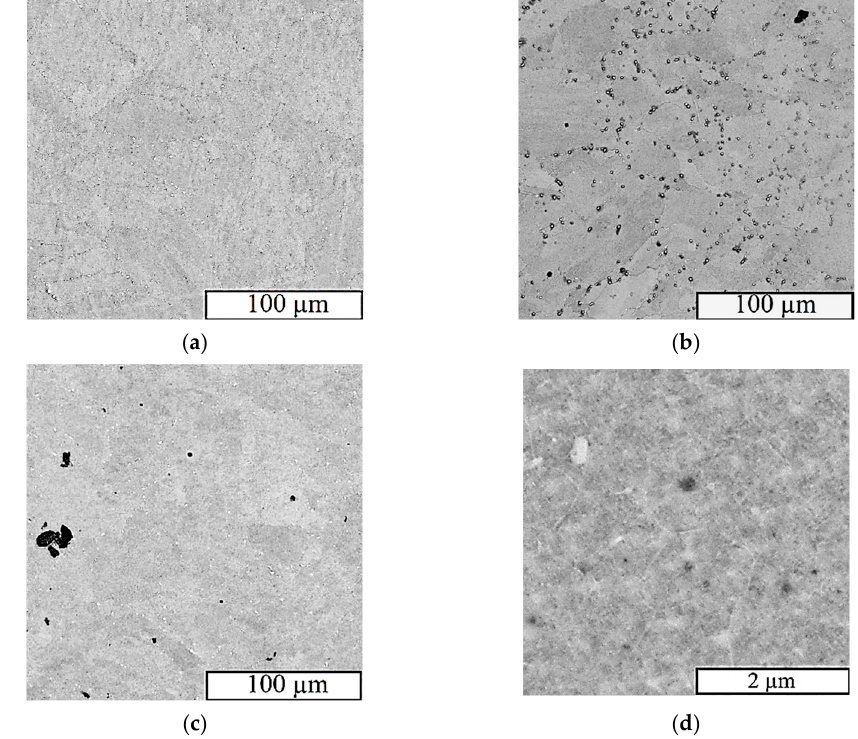
Figure 6. Microstructure of the processed samples (backscattered electron, SEM): ( a ) Inc 718, ( b ) Inc 718 + micron-TiC, ( c ) Inc 718 + nano-TiC, ( d ) nano-TiC particles (dark regions) in Inc 718 matrix.